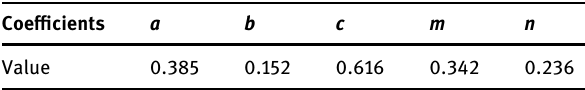
Table 1: Coe ffi cients of the degradation constitutive model Coe ffi cients a